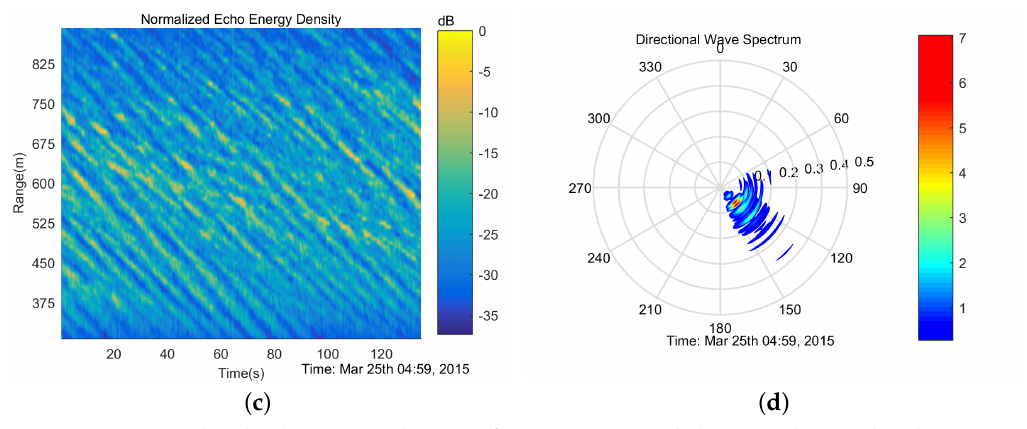
Figure 9. Normalized echo energy density of one antenna and directional wave height spectra.